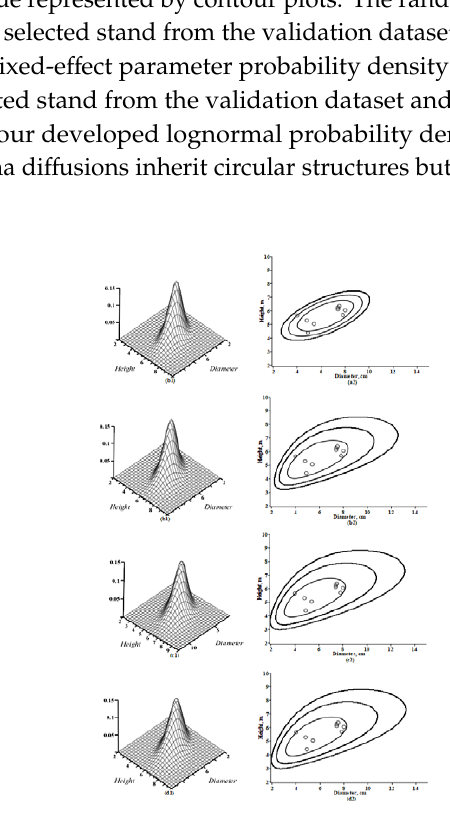
Tree size dimensions vary continuously through natural processes and specific silvicultural activities. Accurate tree-height relationships are necessary for most forest inventories, as knowledge of tree heights is needed to calculate tree volumes, biomass, carbon content, and economic value [34]. The newly developed fixed- and mixed-effect marginal and conditional univariate normal and lognormal probability density functions, which are listed in Tables 1 and 2, respectively, enable the results of the diameter and height behavior to be formalized from an evolutionary (time) perspective,